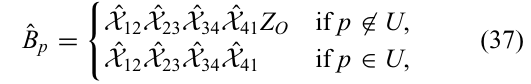
FIG. 4. Semion hopping operators the U boundary (indicated by dashed edges), and (c) near the L boundary (also indicated by dashed edges). In all cases S and CZ operators precede Pauli- X